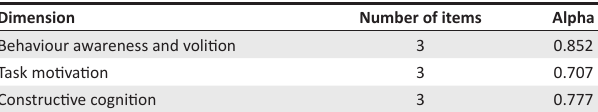
TABLE 6: Reliability estimates for the three dimensions (ASLQ, n = 405).